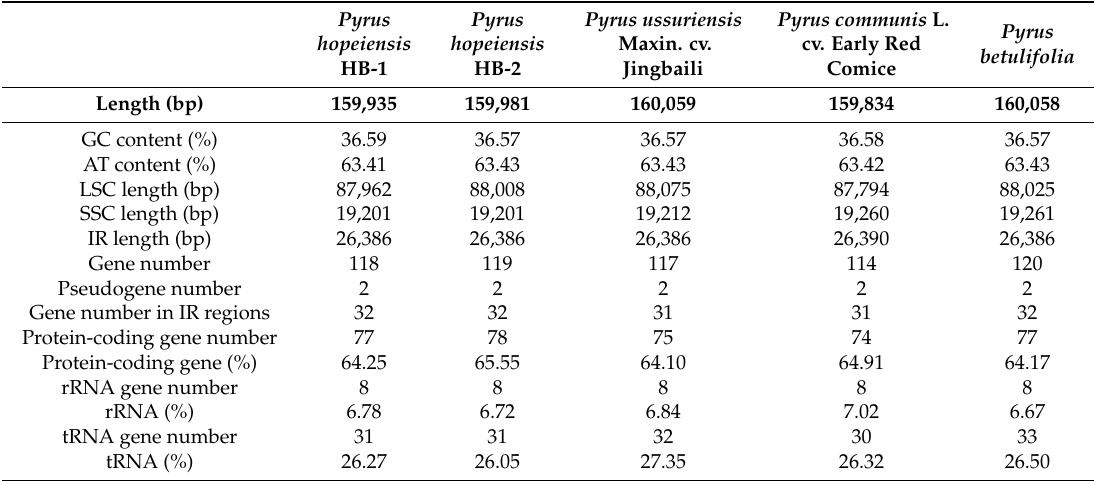
Table 2. Comparison of the basic characteristics of chloroplast Genome in five Pyrus species.